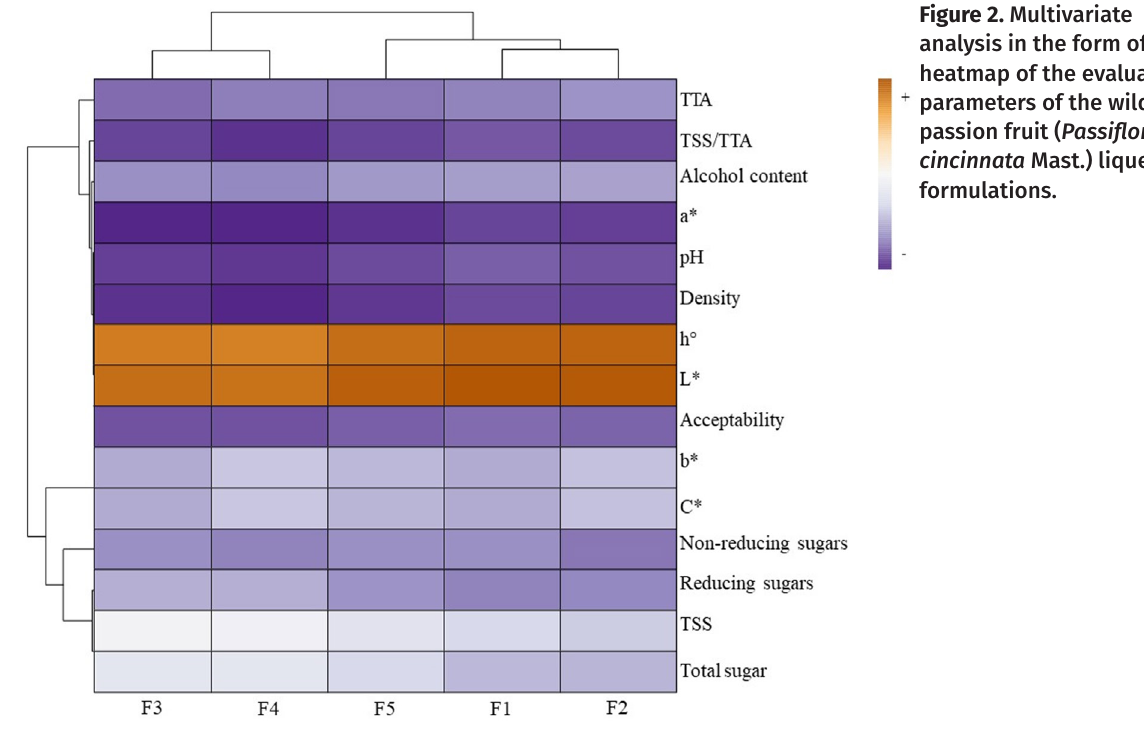
Figure 2. Multivariate analysis in the form of heatmap of the evaluated parameters of the wild passion fruit ( Passiflora cincinnata Mast.) liqueur